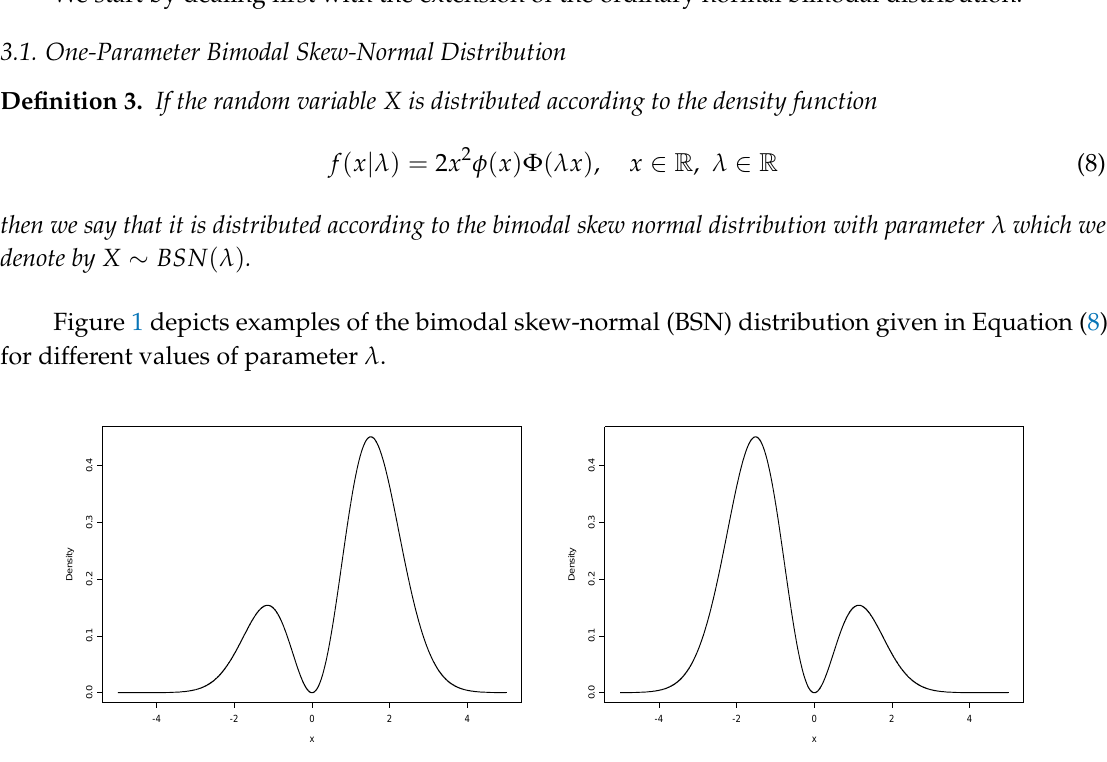
Figure 1. Density BSN ( λ ) with parameter λ = 0.5 (left) and λ = − 0.5